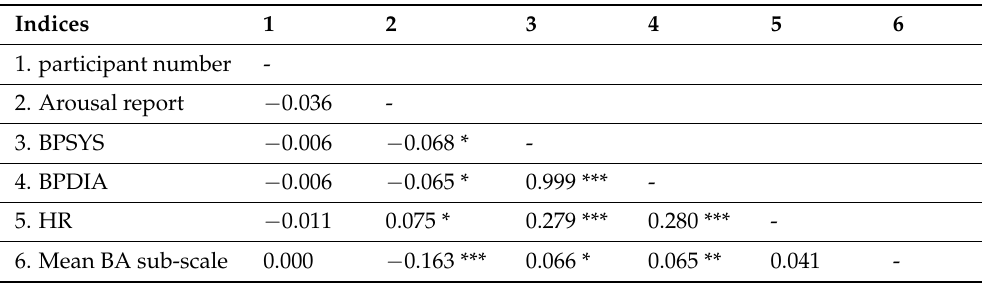
Table A1. Pearson correlations of the measuring tools and measurements throughout the